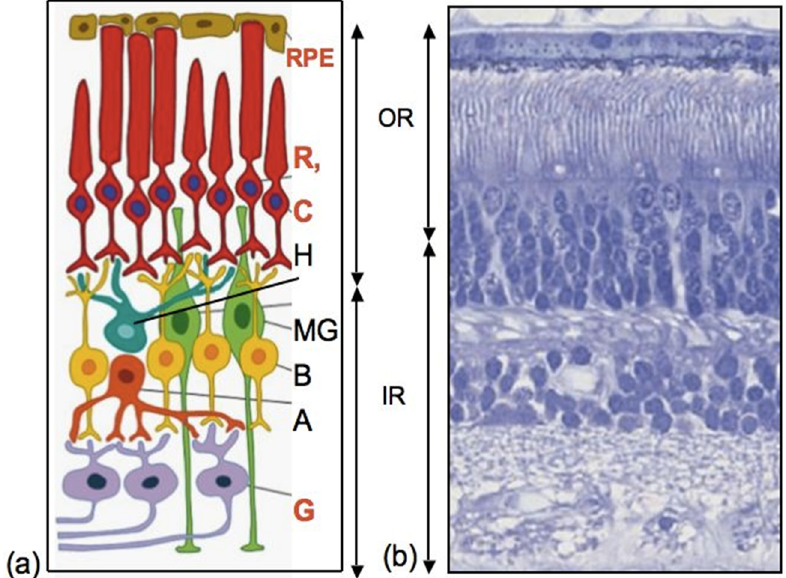
Figure 2. The structure of the retina of vertebrates. ( a ) Schematic diagram, ( b ) histological picture of mouse eye retina. (OR): RPE—retinal pigment epithelium; R—rods, C—cones; H—horizontal cells; (IR): MG—Müller glia; B—bipolars; A—amacrine cells; G—ganglion cells. The most common damage target cells are highlighted in red. OR—outer retina, IR—inner retina.